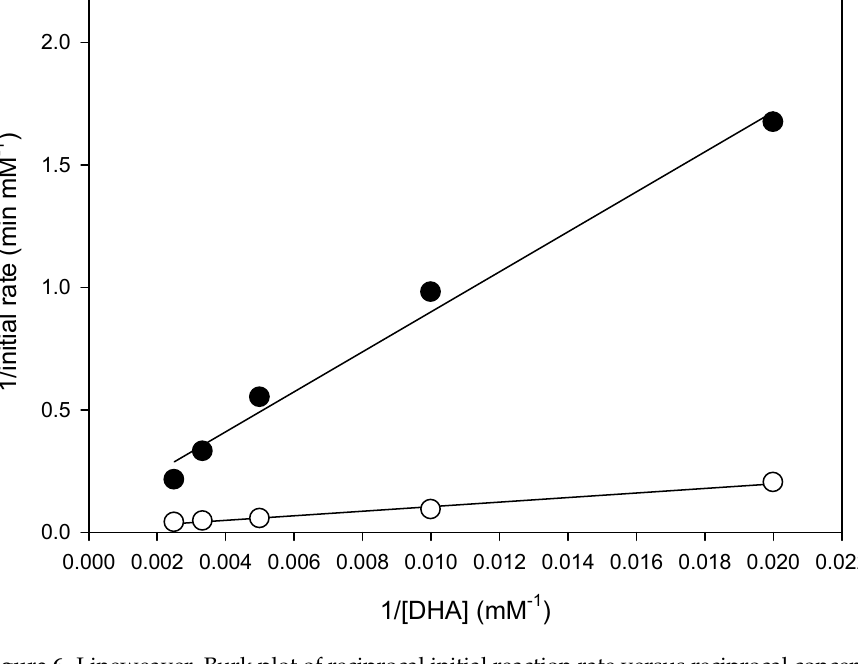
Figure 6. Lineweaver–Burk plot of reciprocal initial reaction rate versus reciprocal concentrations of DHA + EPA concentrate for lipase-catalyzed transesterification in ● shaking bath and ○ ultrasonic bath.